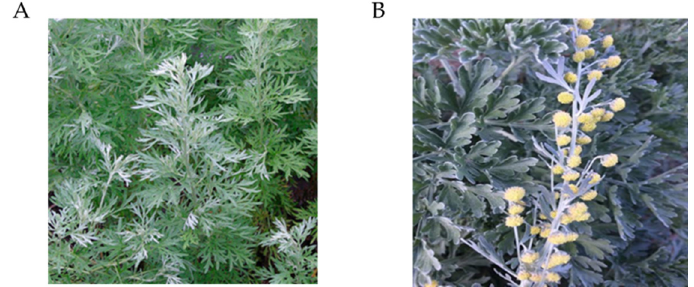
Figure 1. Aerial parts ( A ) and flower ( B ) of Artemisia absinthium [5,6].